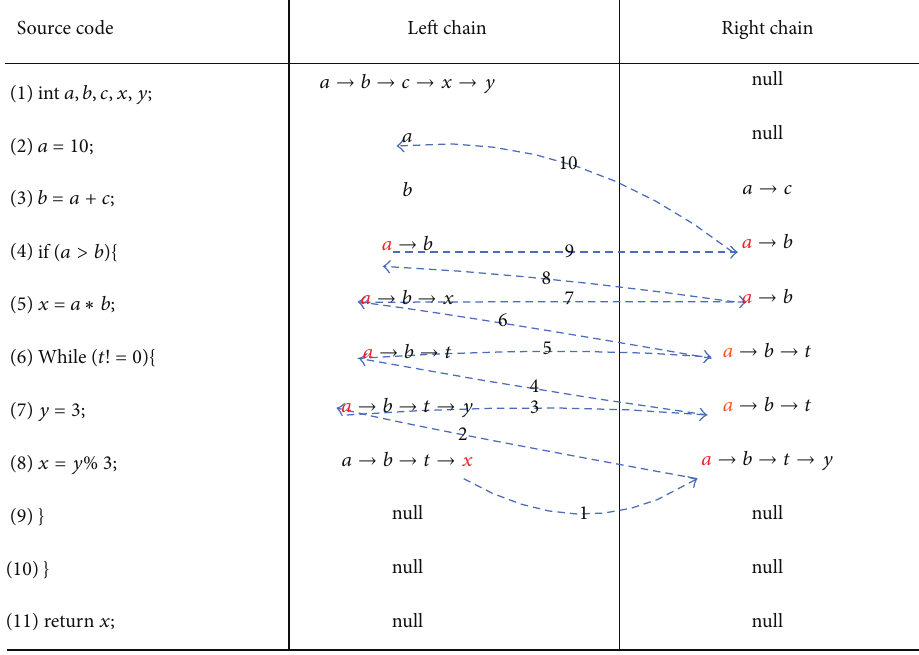
Figure 3: Data-dependent traverse